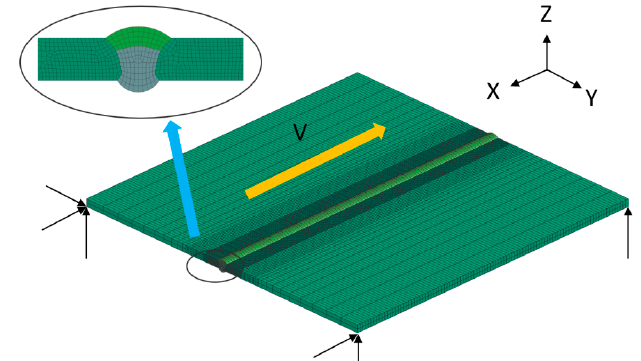
Figure 6. Finite element model.